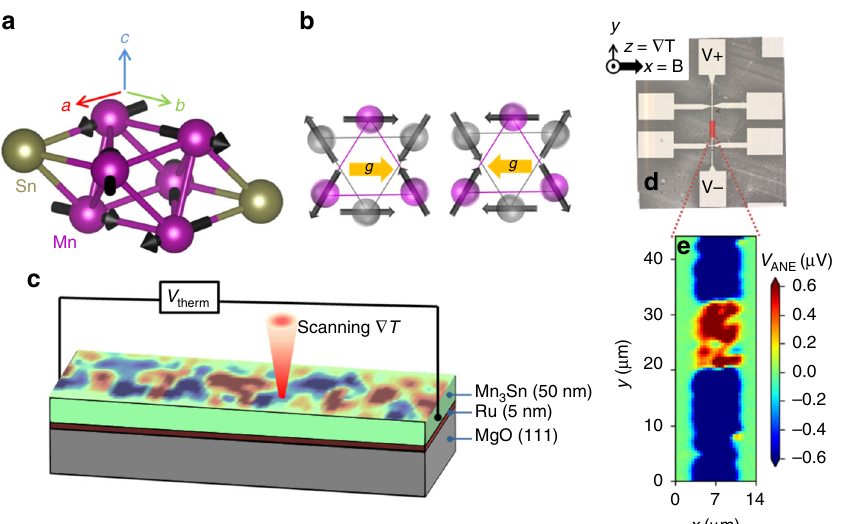
Fig. 1 Crystal structure and experimental setup. a Mn 3 Sn has hexagonal structure with P 6 3 / mmc space group. The magnetic moments (spins) are residing in the c-plane. b Two opposite magnetic domains with the corresponding g vectors (yellow arrows). c Schematics of STGM. Mn 3 Sn fi lms are grown on MgO (111) substrates with a 5 nm Ru underlayer. The laser beam is scanned over the sample surface and the resulting local thermo-voltage sign and magnitude re fl ects the local magnetic properties. d Microscope image of a typical device and the experimental geometry. e Image of the spatially resolved thermo-voltage recorded in the sample (in the part highlighted as a red rectangle in ( d )). The thermo-voltage signal reveals clear magnetic contrast. The experiment was performed at 300 K, with a laser power of 10 mW, and in zero external magnetic fi eld.